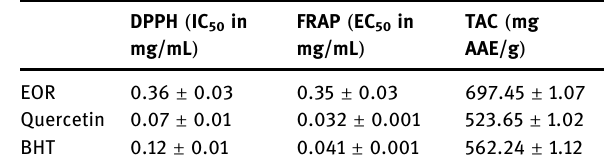
Table 2: Results of antioxidant activity of EOR by DPPH, FRAP,